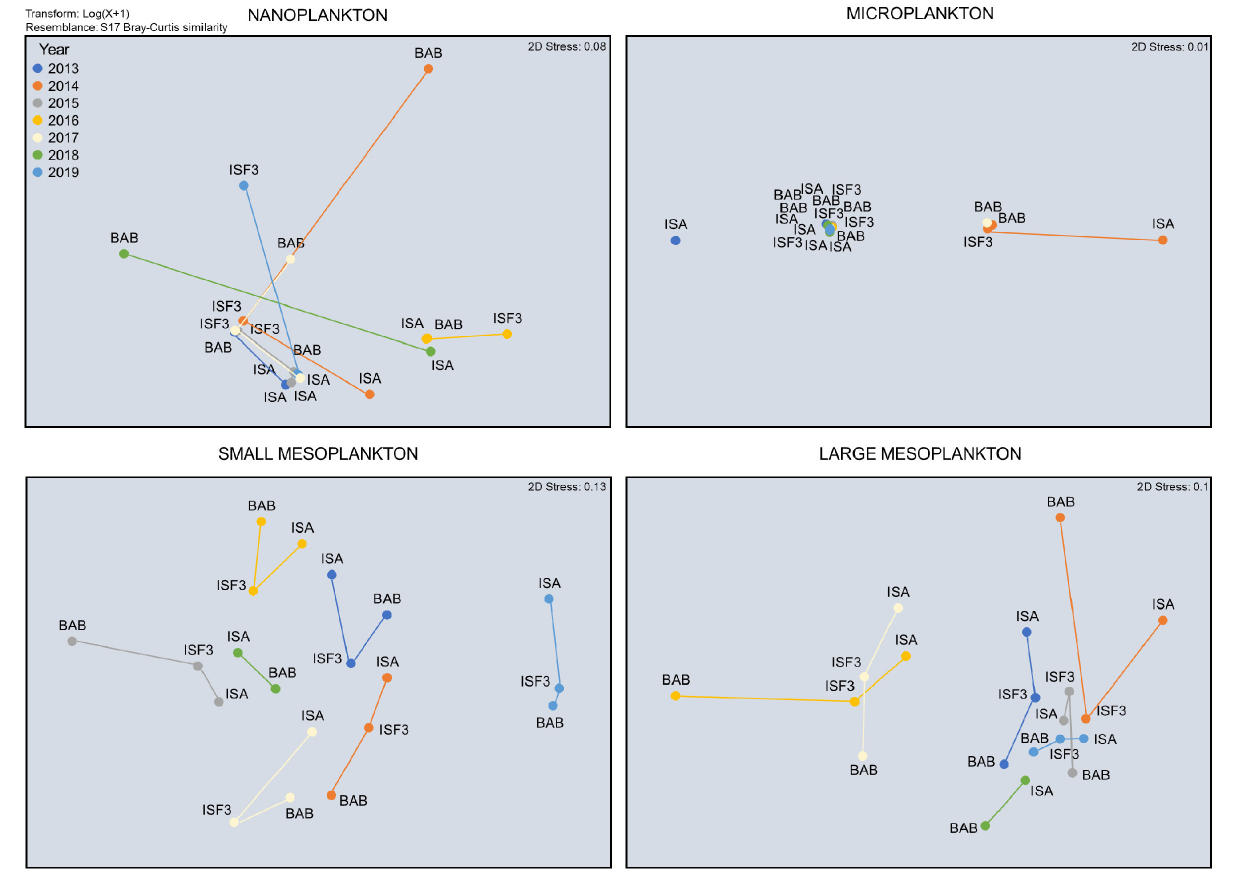
Frontiers in Marine Science |